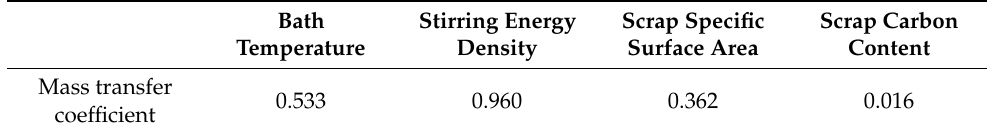
Table 3. Correlation analysis